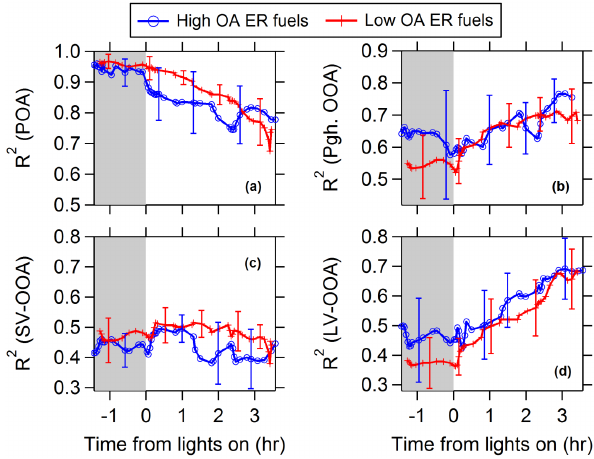
Fig. 4. Evolution of Q-AMS OA mass spectra with photo-oxidation measured during the four experiments with the highest OA mass en- hancement ratios (Burns 42, 43, 63, and 66) and during the four ex- periments with the lowest OA mass enhancement ratios (Burns 40, 55, 57, and 65). The time series show the average coefficient of de- termination ( R 2 ) values for mass spectra measured at each Q-AMS time step (2.5min resolution, with thermodenuder data removed) versus different reference spectra: (a) average POA mass spectrum measured before lights on in each experiment, (b) ambient OOA mass spectrum measured in Pittsburgh (Zhang et al., 2005), (c) unit- mass-resolution semi-volatile OOA mass spectrum (Ulbrich et al., 2009), and (d) low-volatility OOA spectrum (Ulbrich et al., 2009). Grey shaded regions represent primary characterization period be- fore photo-oxidation was initiated. Select error bars ( ± 1 σ) included to show variability in R 2 values between different